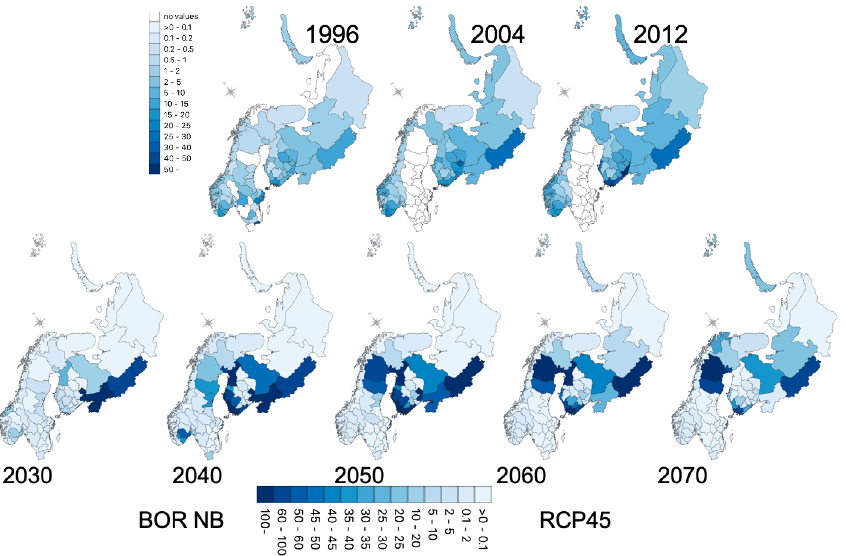
Figure 10. Lyme Borreliosis (BOR) incidence: ( top ) historical period, seven-year averages around each reported year; ( bottom ) projected incidences (seven-year averages) after negative binomial modelling using vegetation types and climate variables, and RCP4.5 land surface model